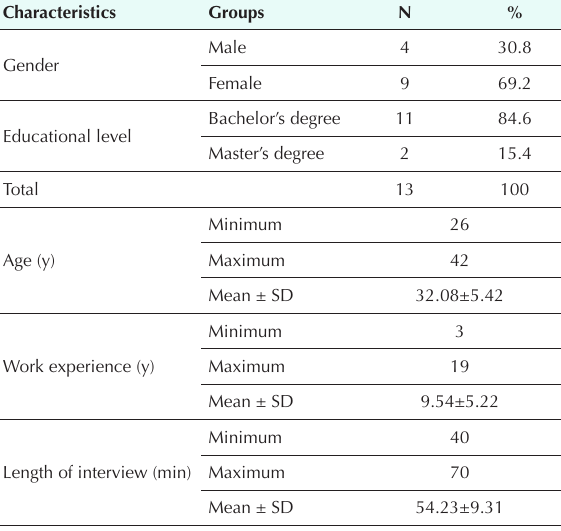
Table 2. The themes and categories of nurses’ experiences of communication during the COVID-19 pandemic